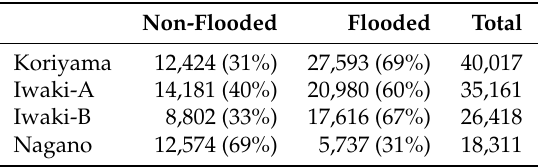
Table 3. Predictions in reference flooded areas.